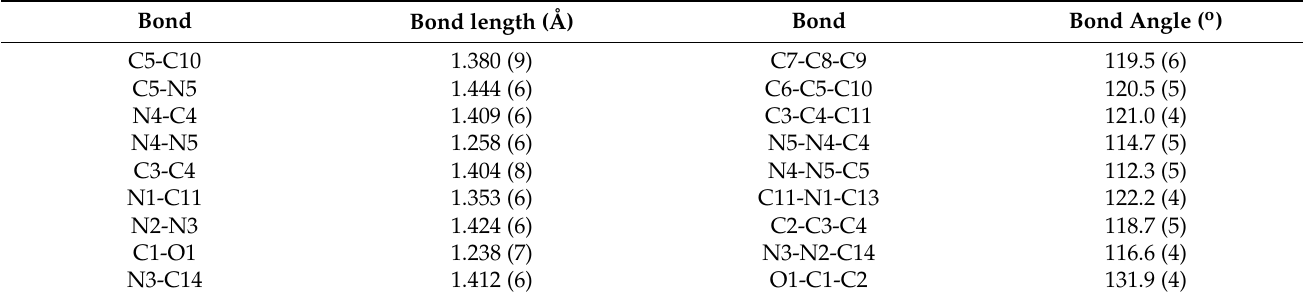
Table 2. Some selected bond lengths and angles for compound 3c